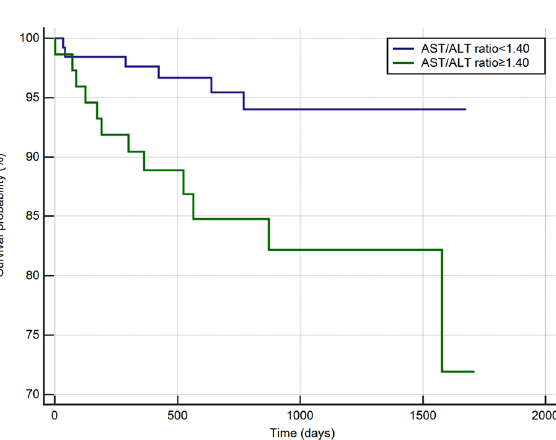
Figure 4. Variables associated with all-cause mortality screened using Lasso regression analysis.